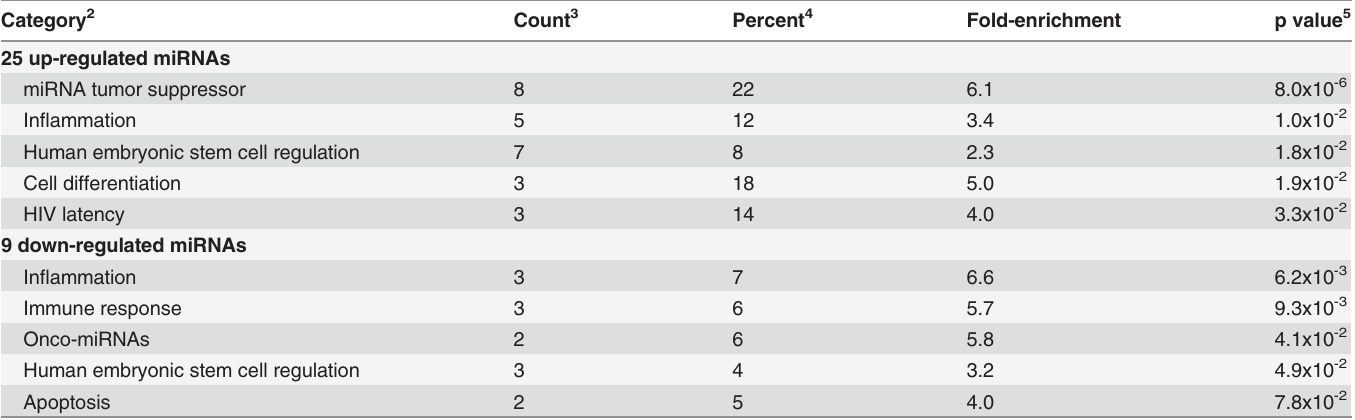
Table 3. Top function categories of miRNAs with significantly different expression in the small airway epithelium of healthy smokers vs healthy nonsmokers 1